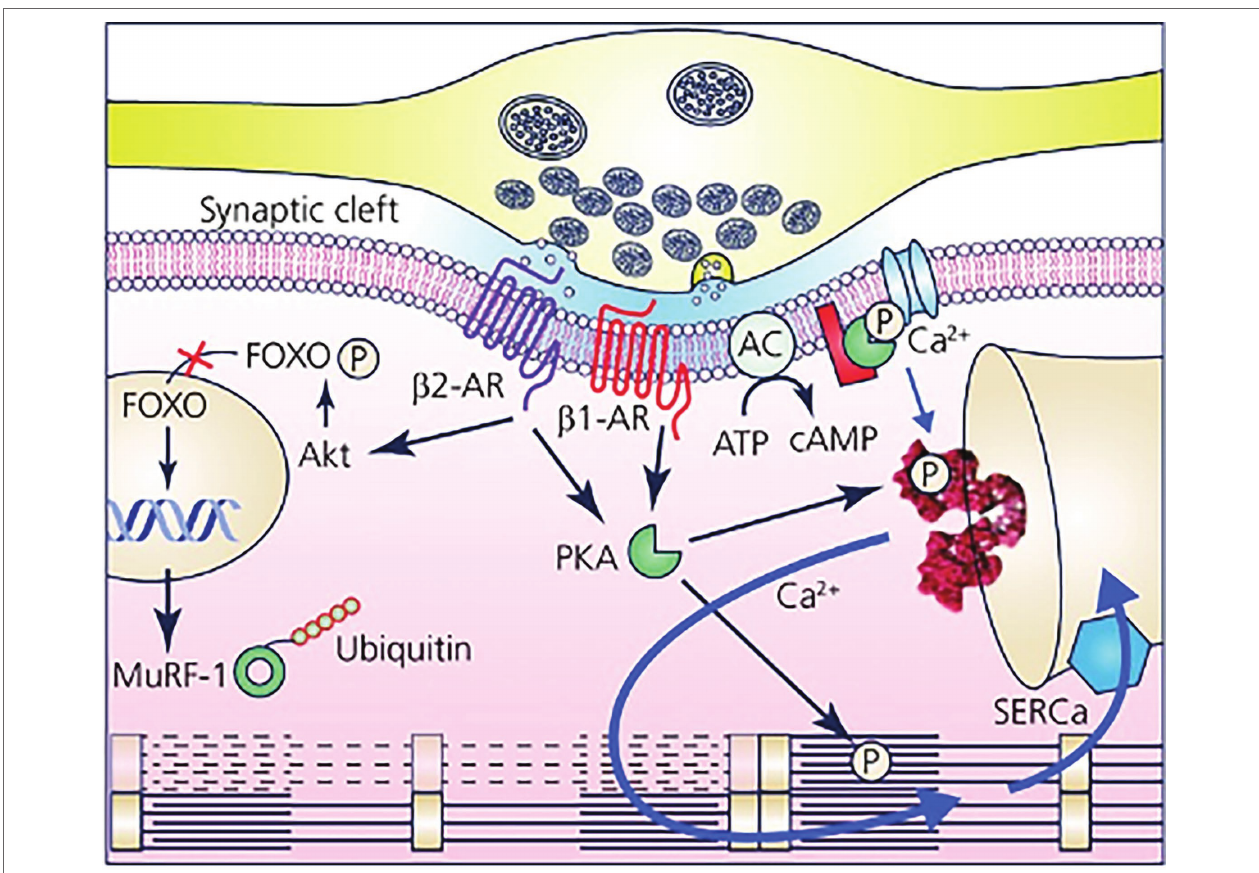
FIGURE 8 | The Neuro-Cardiac Junction is the functional unit of sympathetic neuron-to-cardiomyocytes communication. Schematic of the elements of neuro- cardiac interaction at the varicosity/CM interface. The elements of β -AR dependent signaling activated by noradrenaline released into the synaptic cleft are represented with reference to the β 1-AR and β 2-AR isotypes. The main downstream targets, respectively, associated with gene regulation of trophic genes ( β 2-AR) and Ca 2+ homeostasis ( β 1-AR) are shown. Modified with permission from Zaglia and Mongillo